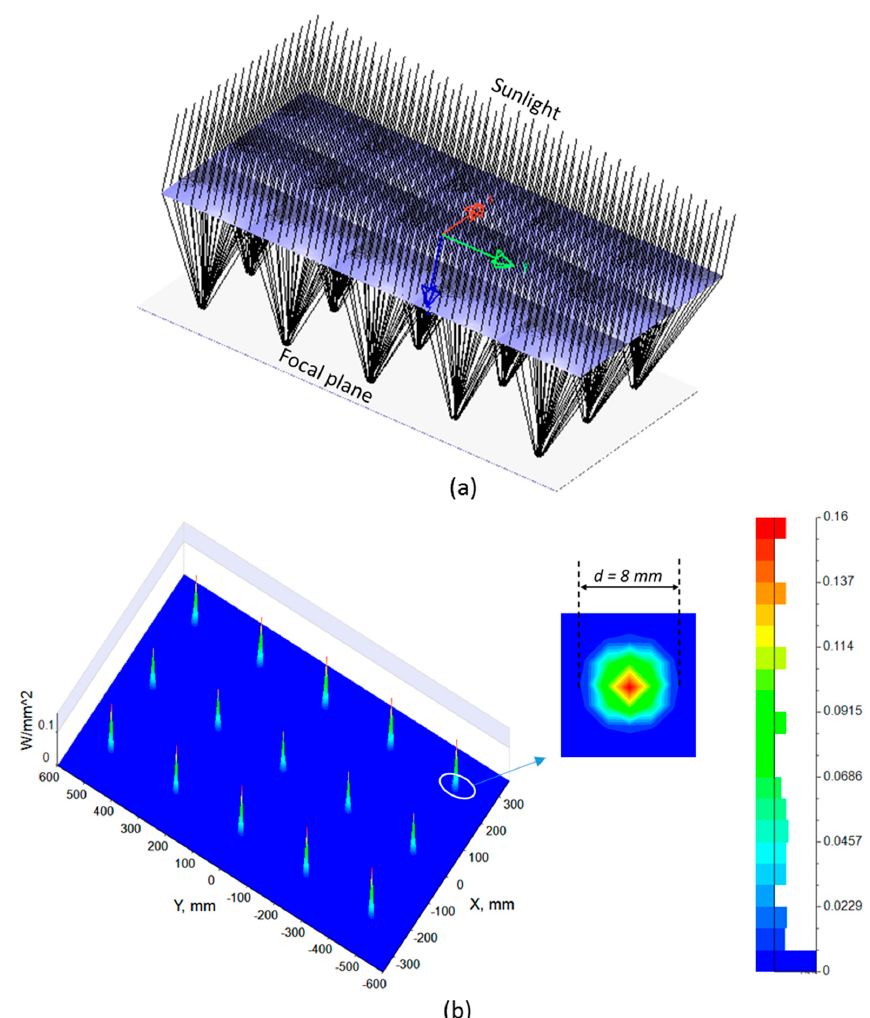
Figure 3. ( a ) The lens array distributes the concentrated sunlight on the focal plane; ( b ) The shape and the size of the concentrated sunlight on the focal